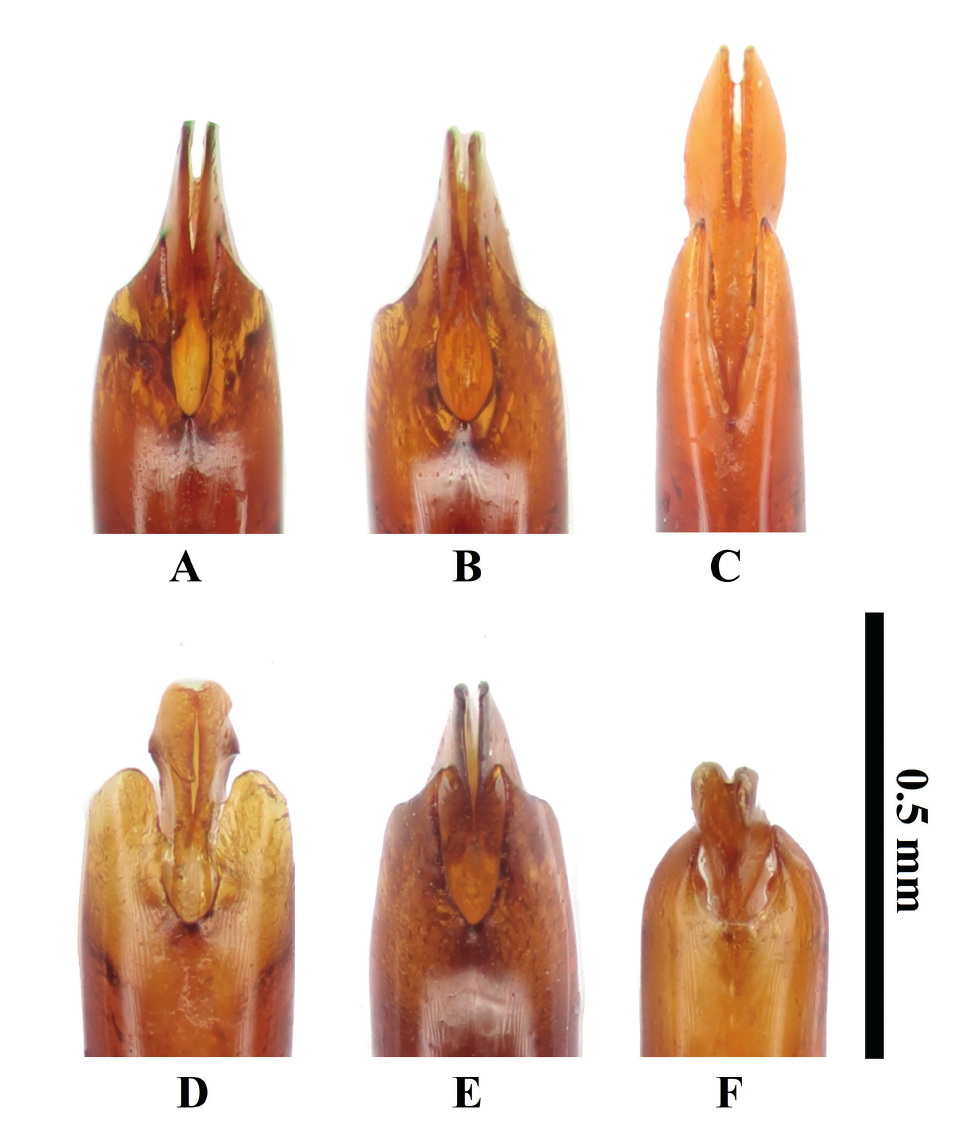
Fig. 7. Close-up of Caccothryptus spp. genitalia ventral apex, ♂, holotype. A . C. brendelli sp. nov. (NHMUK011225276). B . C. arakawae sp. nov. (NHMUK011225268). C . C. championi sp. nov. (NHMUK011225382). D . C. larryi sp. nov. (NHMUK011225324). E . C. tardarsauceae sp. nov. (NHMUK011225274). F . C. abboti sp. nov.